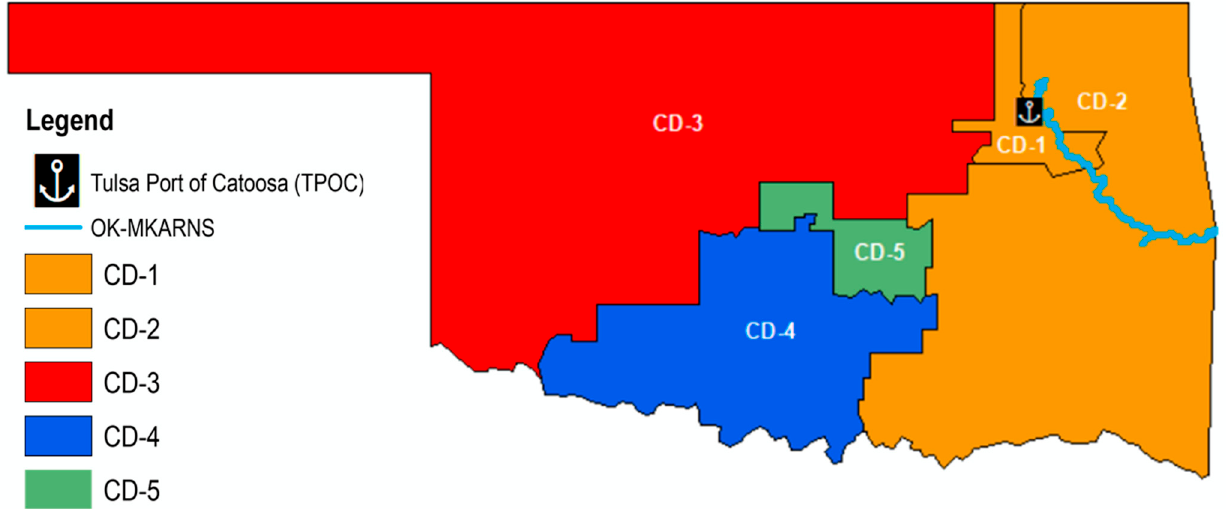
Figure 1. Study Region.